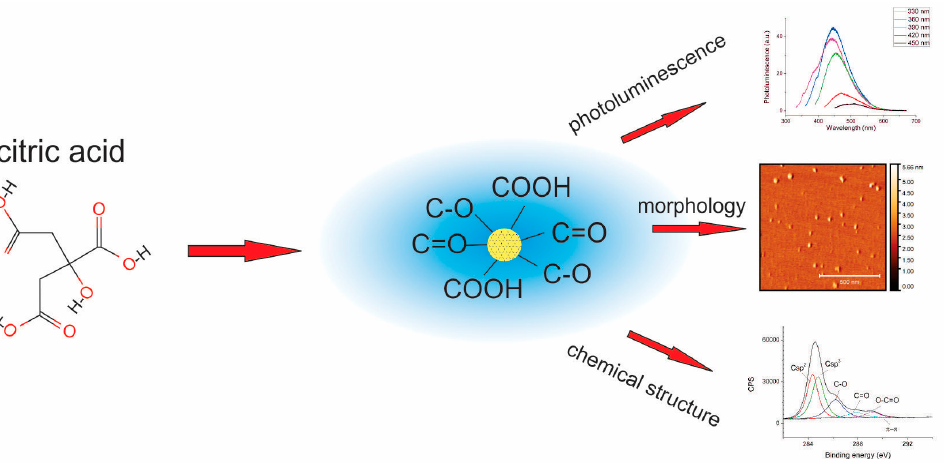
Figure 6. Chemical structure, morphology, and photoluminescence of CQDs synthesized from hydroquinone in the hydrothermal reactor at 180 °C for 12 h. Detailed information can be found in ref. [29].